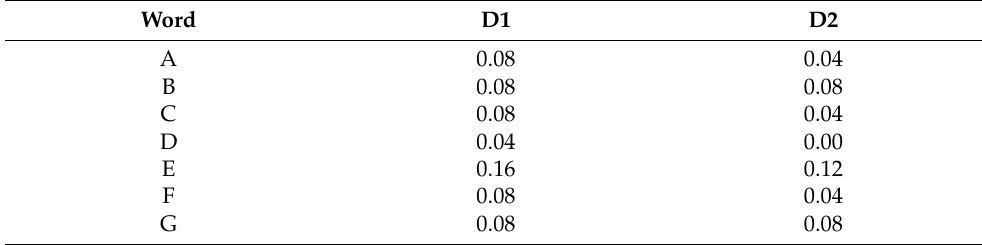
Table 4. Frequency of feature words in documents.